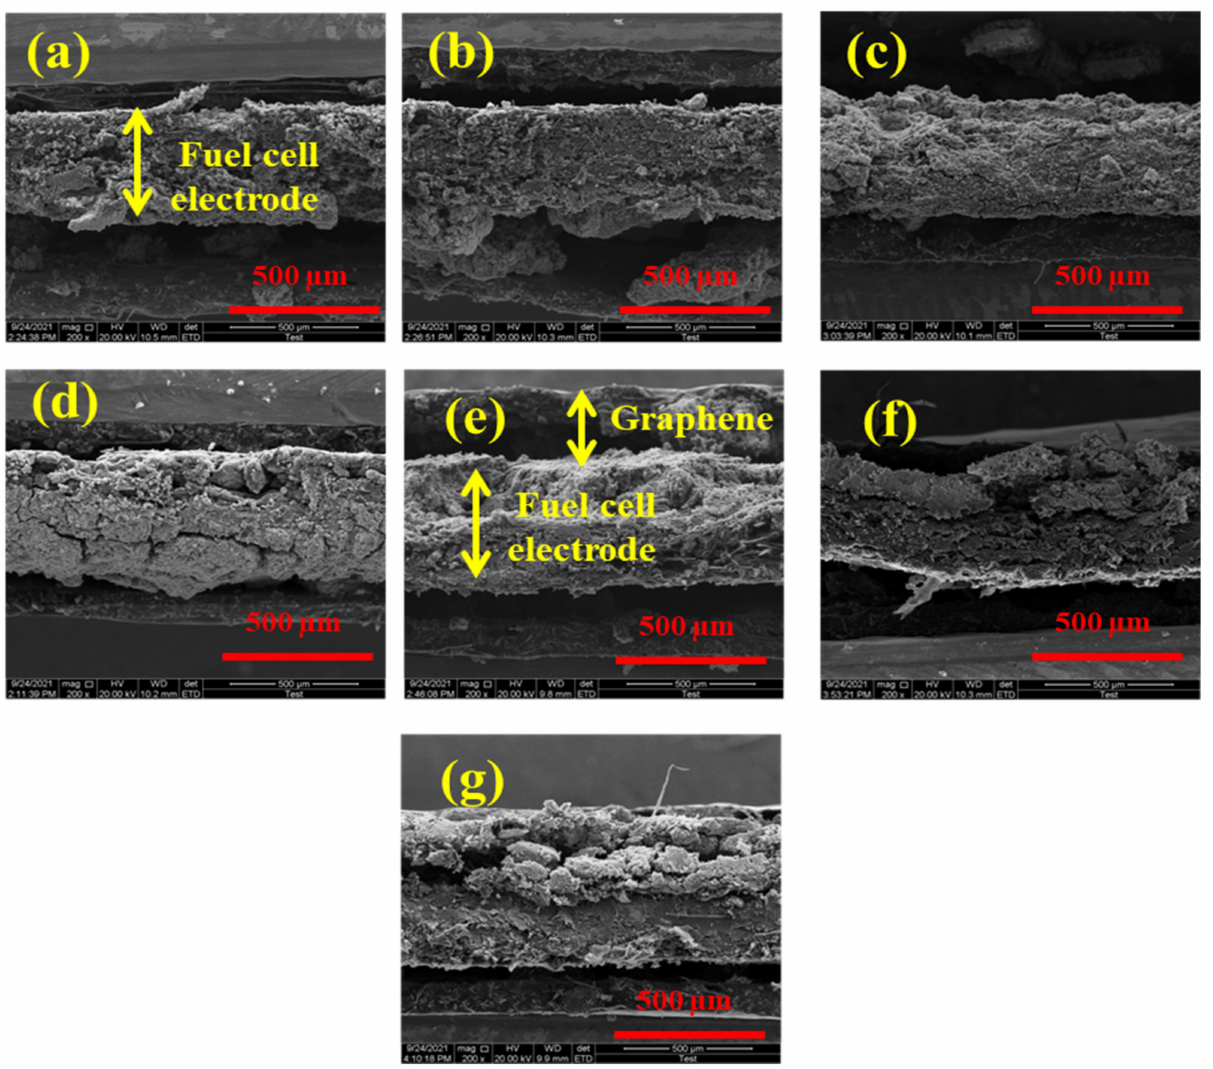
Figure 4. Cross-sectional SEM view of electrodes—standard (( a ) 0 wt.% graphene) and containing graphene (( b ) 2.5 wt.% graphene, ( c ) 5 wt.% graphene, ( d ) 7.5 wt.% graphene, ( e ) 10 wt.% graphene, ( f ) 20 wt.% graphene) and ( g ) 25 wt.% graphene showing varied crack separation